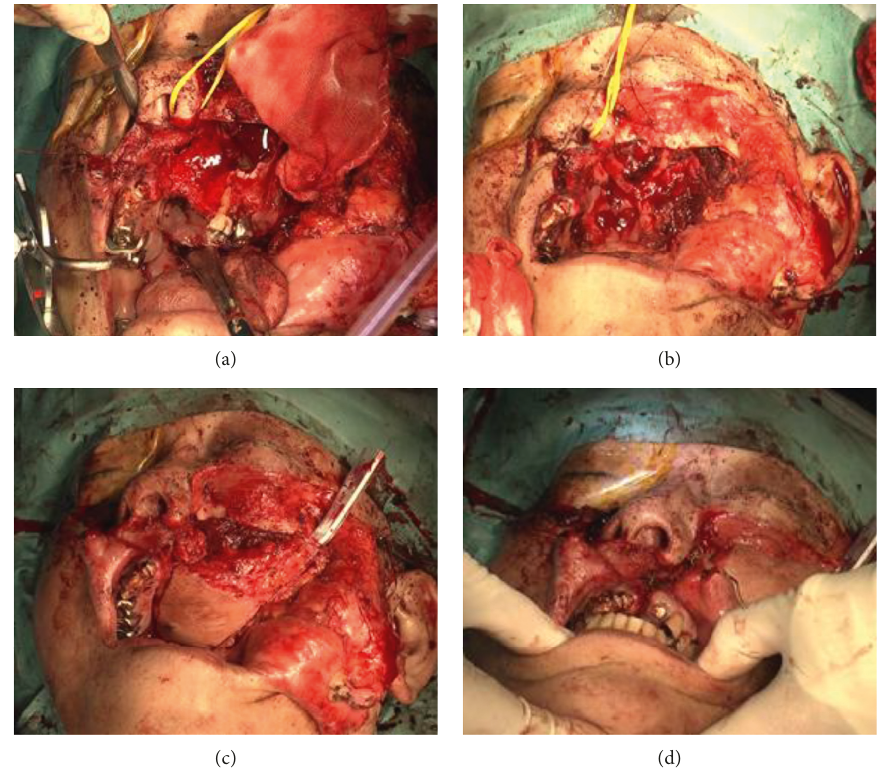
Figure 3: Surgical procedure of the modified partial swing approach. (a) Weber–Fergusson incision was made, and an anterior maxillary flap was elevated. (b) Tumor was excised. (c) Reconstruction was performed with an ALT flap. (d) The maxilla flap was repositioned and fixed with miniplate.